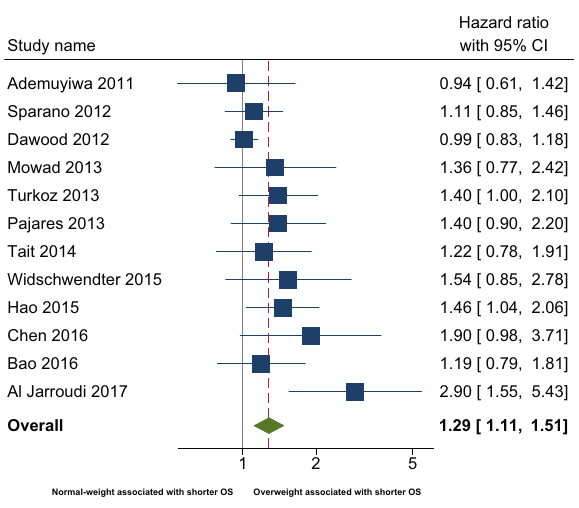
Fig. 3 Meta-analysis of observational studies comparing overall survival in overweight and normal-weight. * Overall survival was de fi ned as time from breast cancer diagnosis to death of any